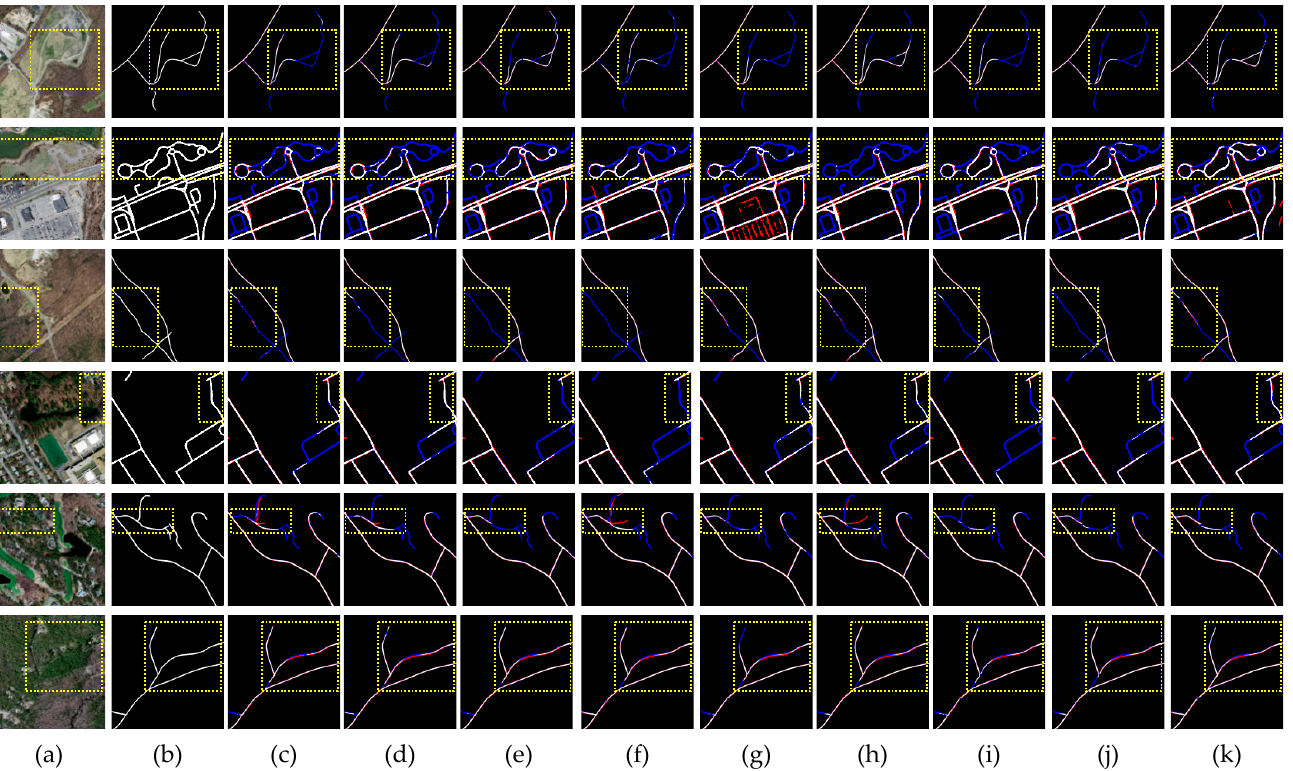
Figure 7 Comparison of visualization results between MECA-Net and other road extraction methods based on the Massachusetts dataset. (a) Image; (b) Label; (c) RoadNet results; (d) based on the Massachusetts dataset. ( a ) Image; ( b ) Label; ( c ) RoadNet results; ( d ) SegNet results; SegNet results; (e) NL-LinkNet results; (f) UNet results; (g) DeepLabv3+ results; (h) PP-LinkNet ( e ) NL-LinkNet results; ( f ) UNet results; ( g ) DeepLabv3+ results; ( h ) PP-LinkNet results; ( i ) LinkNet results; (i) LinkNet results; (j) D-LinkNet results; (k) MECA-Net results. White: true positive. results; ( j ) D-LinkNet results; ( k ) MECA-Net results. White: true positive. Black: true negative. Black: true negative. Blue: false negative. Red: false positive. Blue: false negative. Red: false positive.